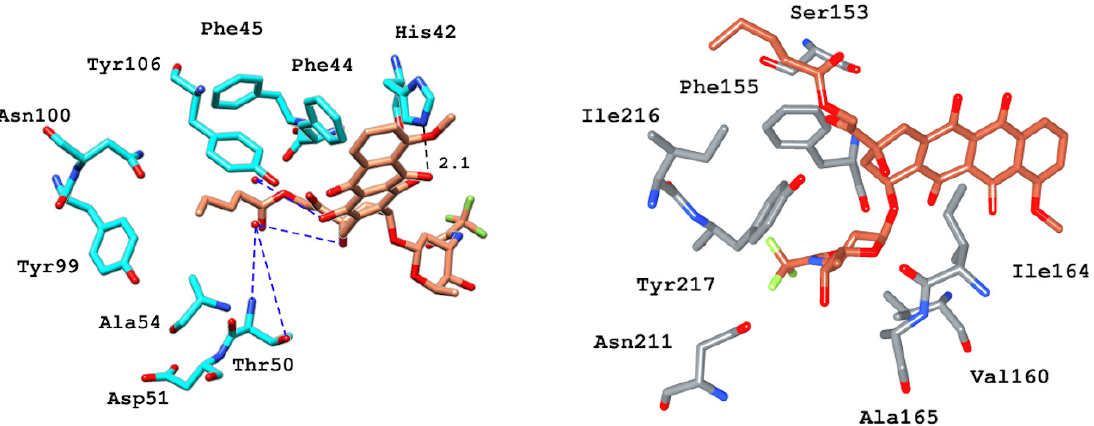
Figure 8. Binding and interaction pattern of the ZINC28232750 in the acetyl–lysine pocket of BRD9 (cyan) and BRD7 (gray) [17].